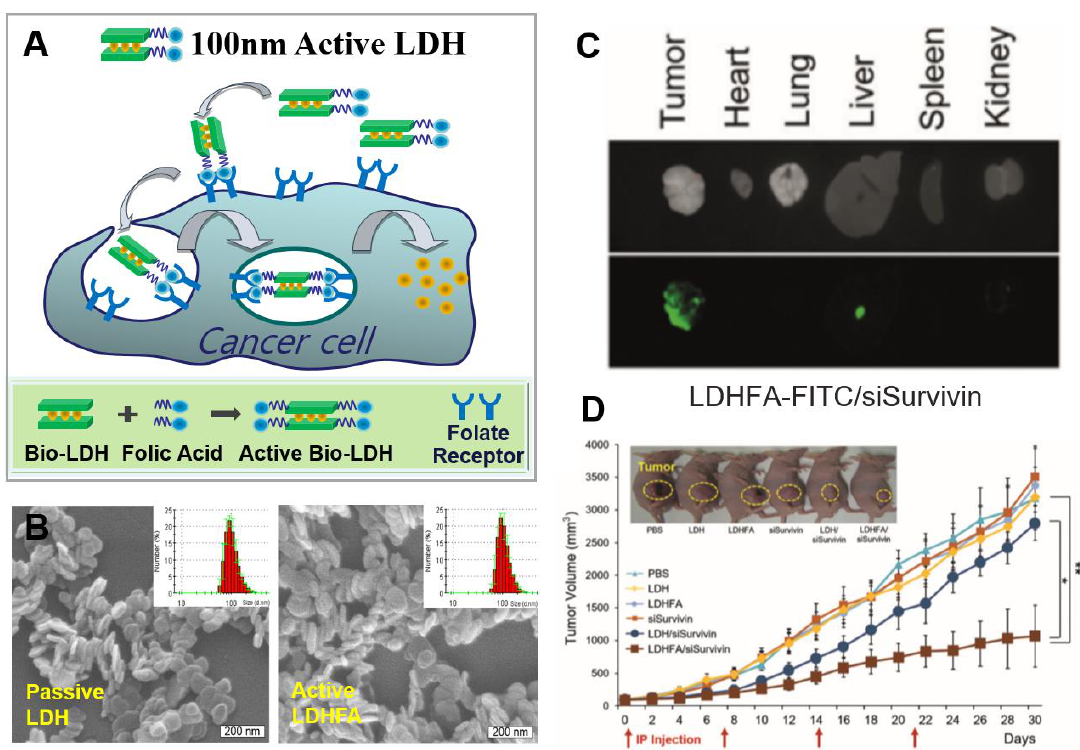
Figure 3. ( A ) Schematic illustration of intracellular trafficking pathway and synthetic procedure of active bio-LDHFA nanoparticles, ( B ) SEM images and size distributions of passive LDH and active LDHFA, ( C ) ex vivo biodistribution of the LDHFA-FITC-siSurvivin in the xenograft model: optic (top) and fluorescence (bottom) images, ( D ) in vivo anti-tumor efficacy of KB tumor-bearing mice treated for 30 days with each sample via intraperitoneal injection once every seven days (inset photo image shows the mice on 18 days post-treatment), reproduced from [6], with permission from Wiley-VCH Verlag GmbH & Co. KGaA, 2016.